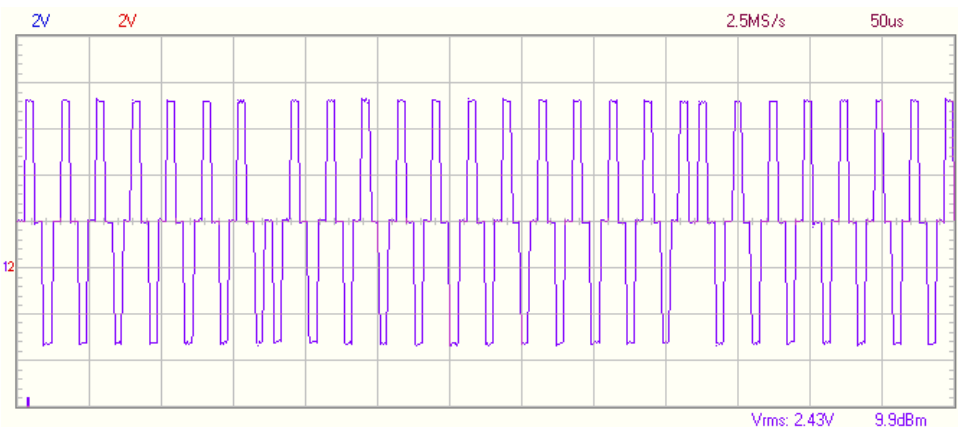
Figure 12. Modified sine wave